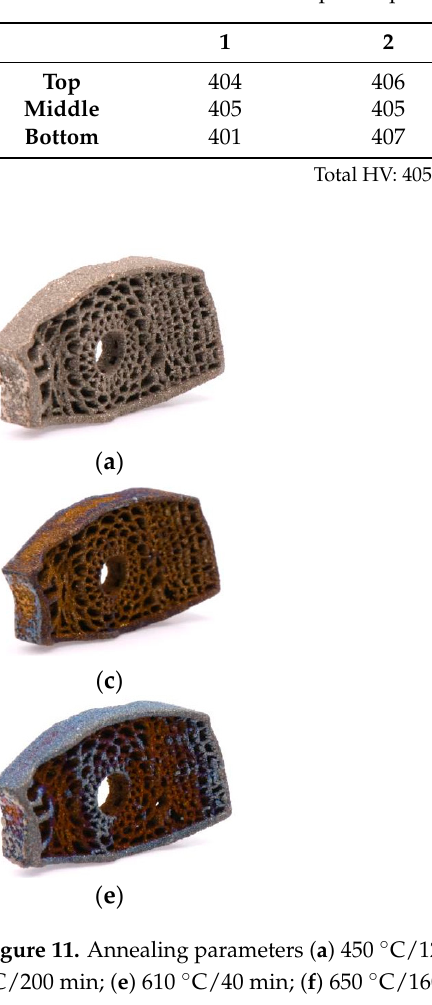
Table 8. The uniform design experimentation (UDE) method for annealing parameters.